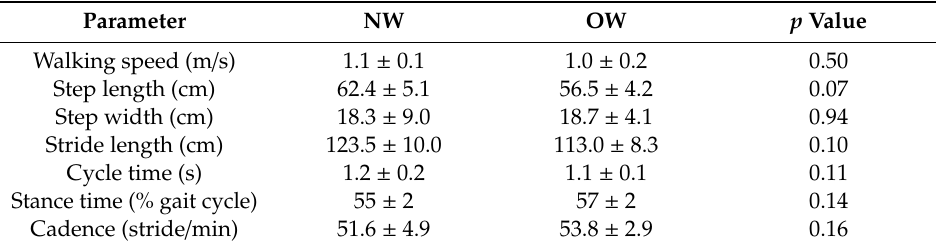
Table 2. Spatio-temporal parameters (mean ± standard deviation).